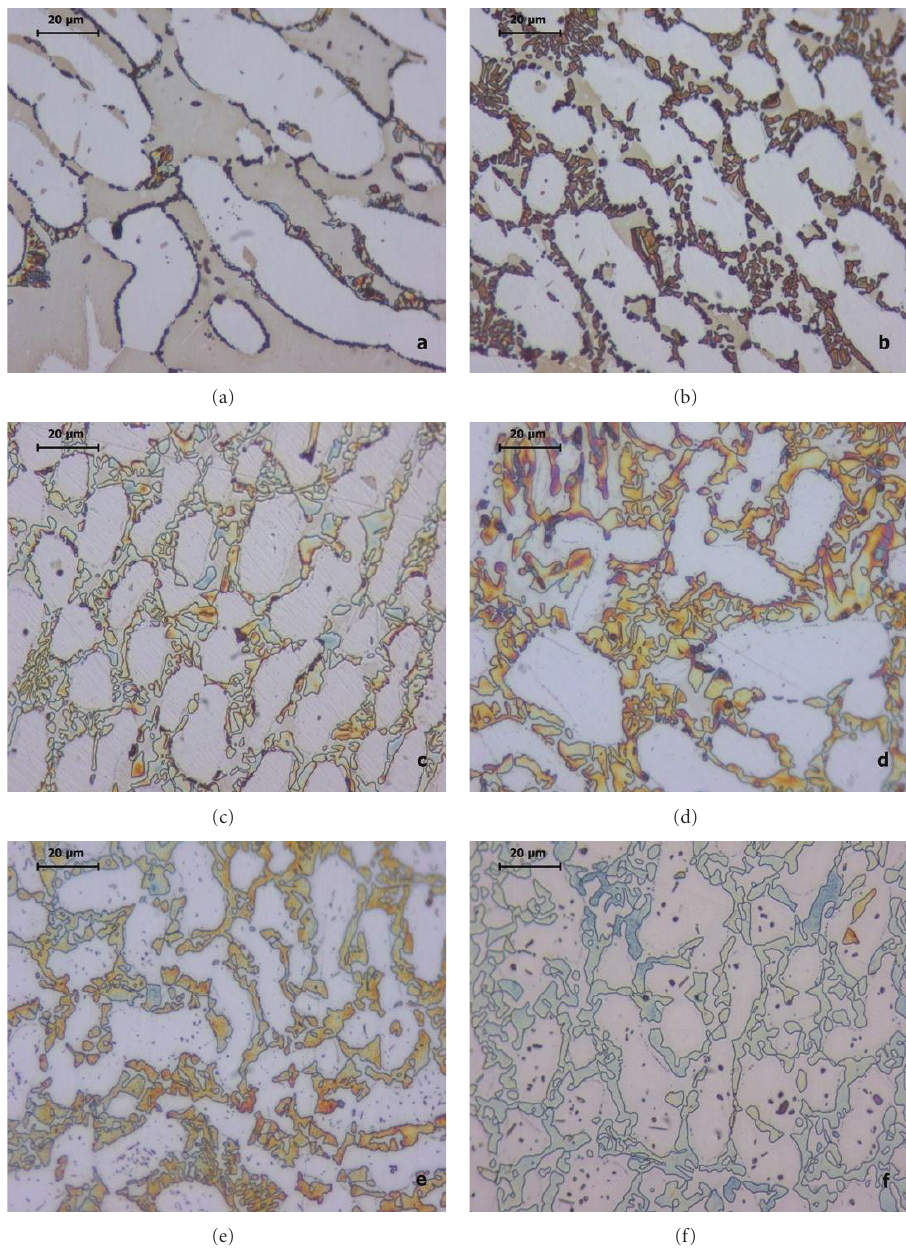
Figure 2: Optical micrographs obtained after ageing at 800 ◦ C by etching with NaOH reagent. (a) 100 min, (b) 316 min, (c) 1000 min, (d) 3162 min, (e) 10000 min, (f) 31622 min, (austenite in white, ferrite in gray, sigma precipitates in black).